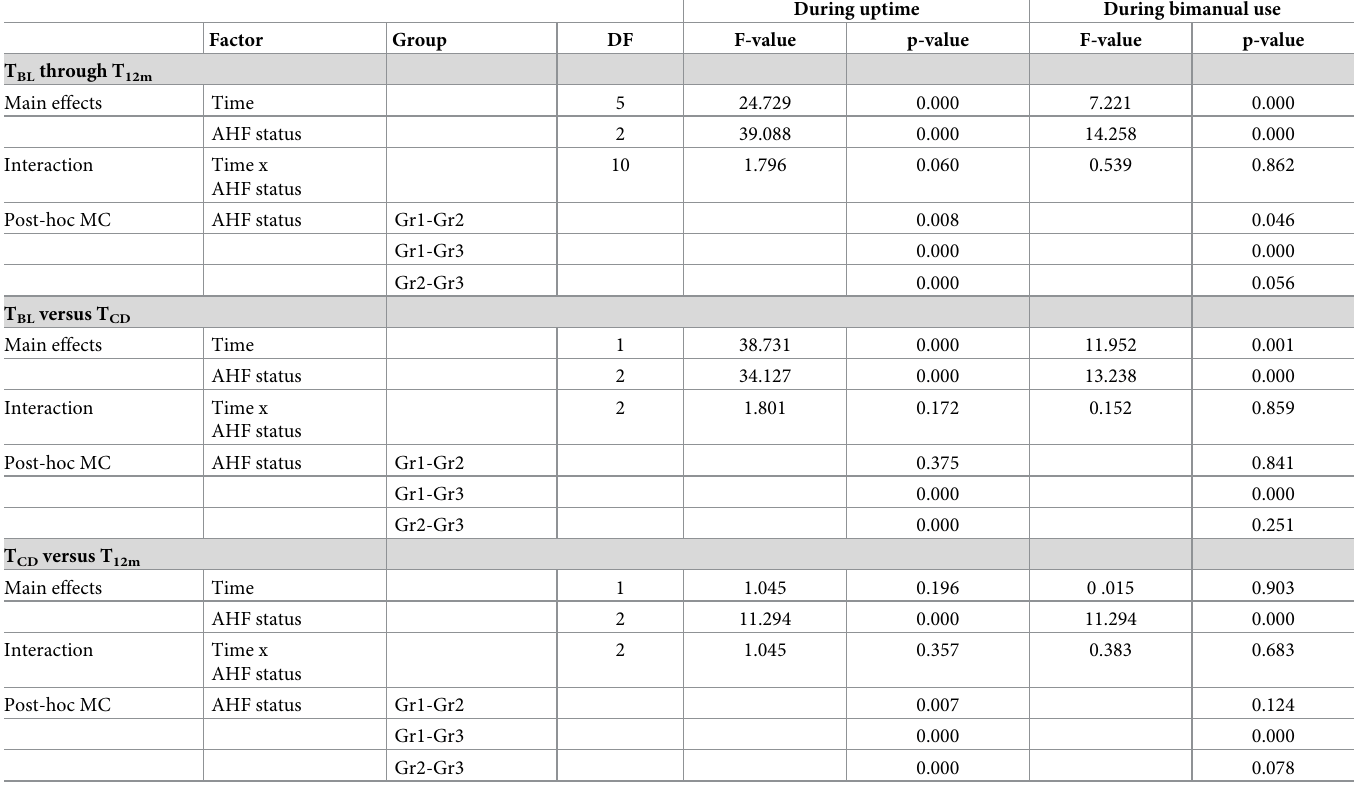
Table 4. Statistics regarding Intensity-of-arm-hand-use ratios between affected and non-affected